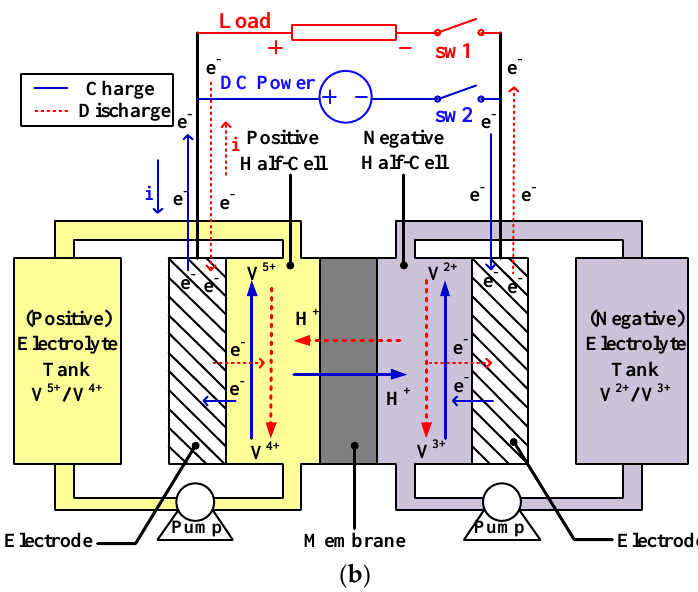
Figure 2. Schematic diagrams of a VRFB system: ( a ) VRFB hardware system; ( b ) charging and discharging operations of a single-cell VRFB.